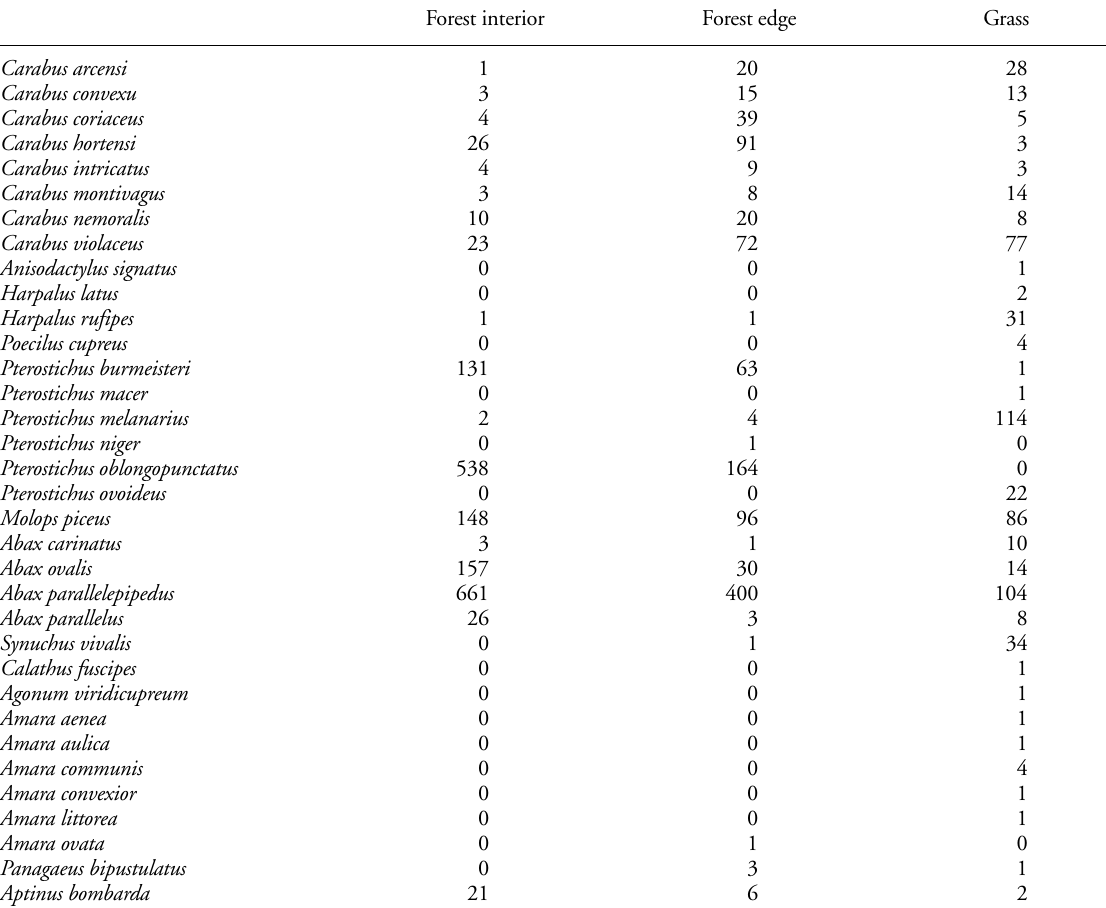
Table 1. Number of individuals of collected carabids for the two-year study period.